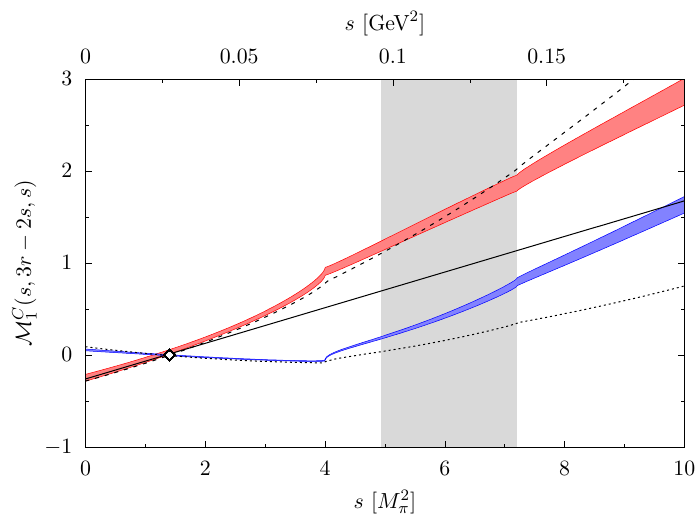
with the respective tree and one-loop level Figure 4 . Comparison of the dispersive amplitude M C 1 expressions obtained from χ PT along the critical line s = u . The real and imaginary parts of the dispersive amplitude are given by the red and blue bands, which cover the range of statistical and systematical uncertainties added in quadrature. The tree level result is depicted by the solid black line, while the one-loop real part is given by the dashed and the imaginary part by the dotted black lines. The black open diamond denotes the position of the Adler zero in one-loop χ PT. The physically allowed region for the η → 3 π decay is depicted by the gray